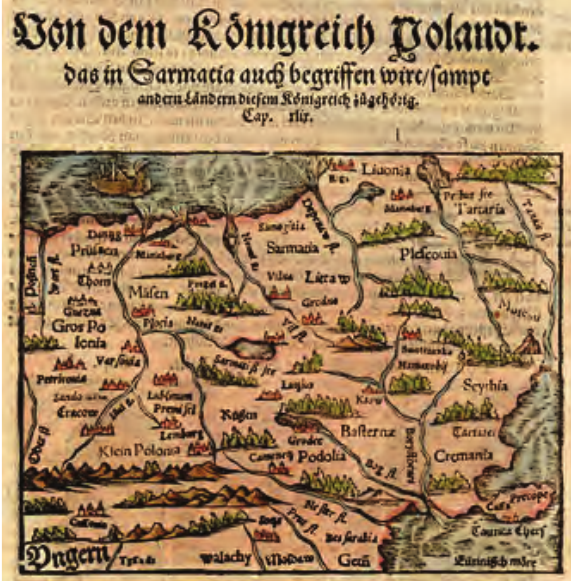
Fig. 5. Map of Midle Europa by S. Munster, 1578